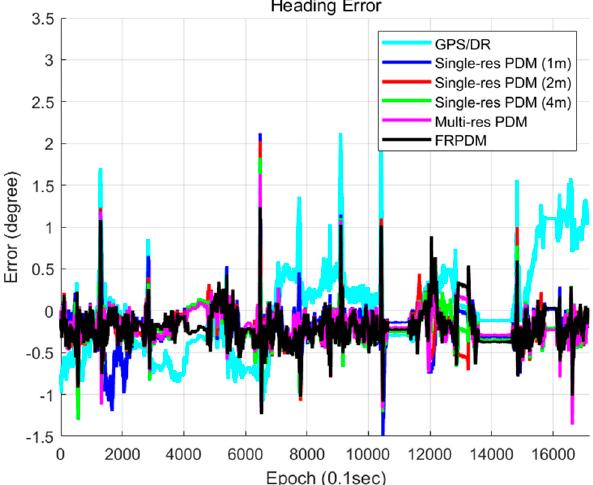
Figure 32. Heading error (map type).